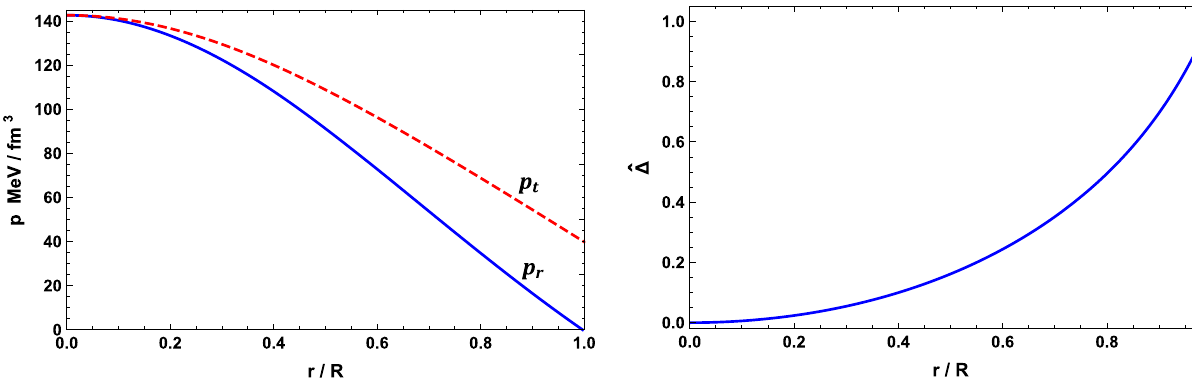
Fig. 2 The pressure and ˆ (cid:23) = ( p t − p r )/ p t are plotted against r / R by taking the same values as in Fig. 1 for PSR